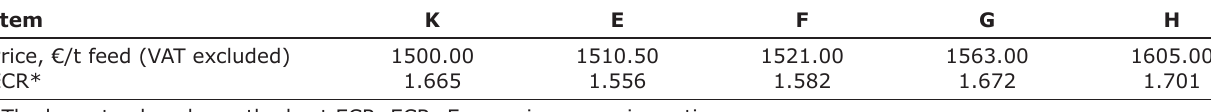
Average individual weight gain, g